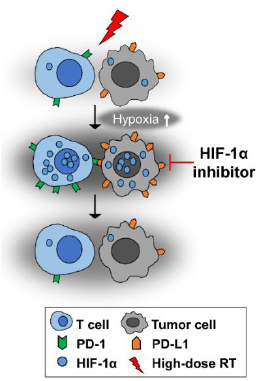
Figure 6. High-dose-per-fraction irradiation causes vascular damage in tumors, thereby increasing hypoxia. Consequently, the expressions of HIF-1 α and its downstream targets PD-L1 and PD-1 are increased. HIF-1 α inhibition may abrogate the irradiation-induced increases in HIF-1 α , PD-L1 and PD-1